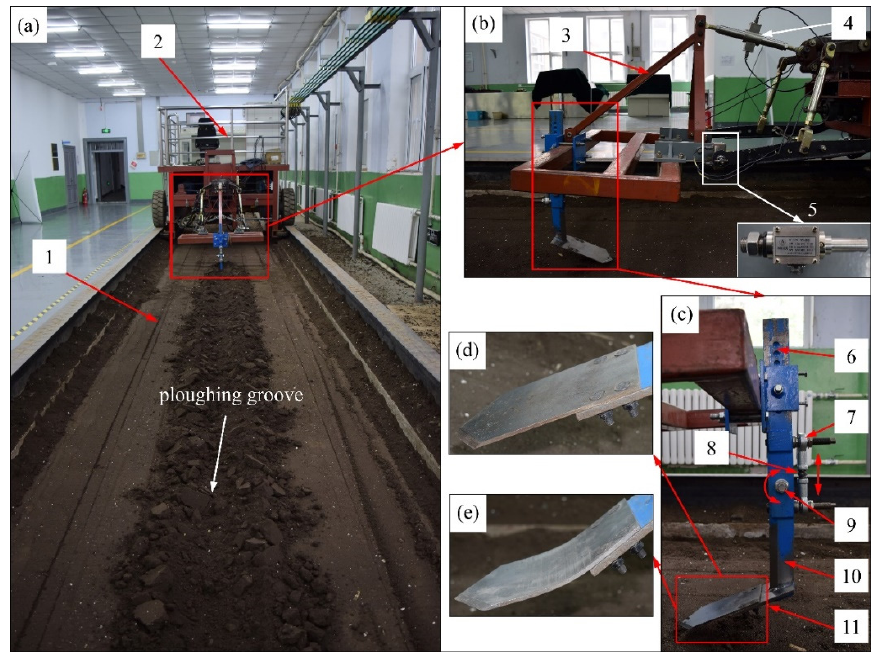
Figure 6. Soil bin experiments for a single potato digging shovel. ( a ) Soil bin experiments system, ( b ) test system, ( c ) connecting shank, ( d ) DZ, ( e ) YS, (1) soil bin, (2) tractor, (3) mounting frame, (4) up- per pull rod sensor, (5) lower suspension pin sensor, (6) upper shank, (7) joint bearing, (8) double-end stud, (9) rotating shaft, (10) lower shank and (11) potato digging